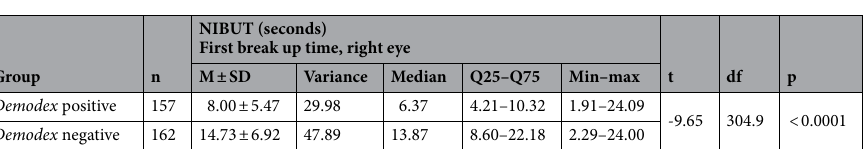
Table 2. Descriptive statistics of the first break up time in the right eye in patients with and without Demodex infestation and results of the t-test with Cochran–Cox correction. Arithmetic mean (M), standard deviation (SD), interquantile range (Q25–Q75), degrees of freedom (df), t-value (t), p-value (p).